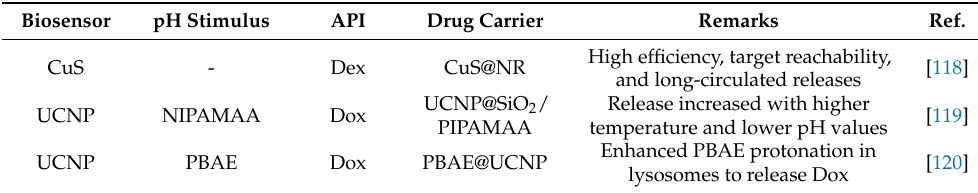
Table 2. Photothermal triggers added to pH stimulus biosensors in drug carriers with remarks